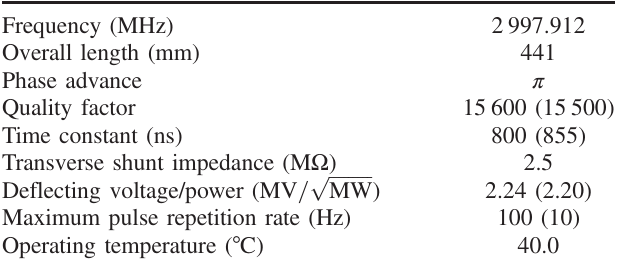
TABLE VIII. Main parameters of the S-band deflecting cavity. Where available and of relevance measured values are given in brackets. The time constant refers to the rise time of the electromagnetic field inside the